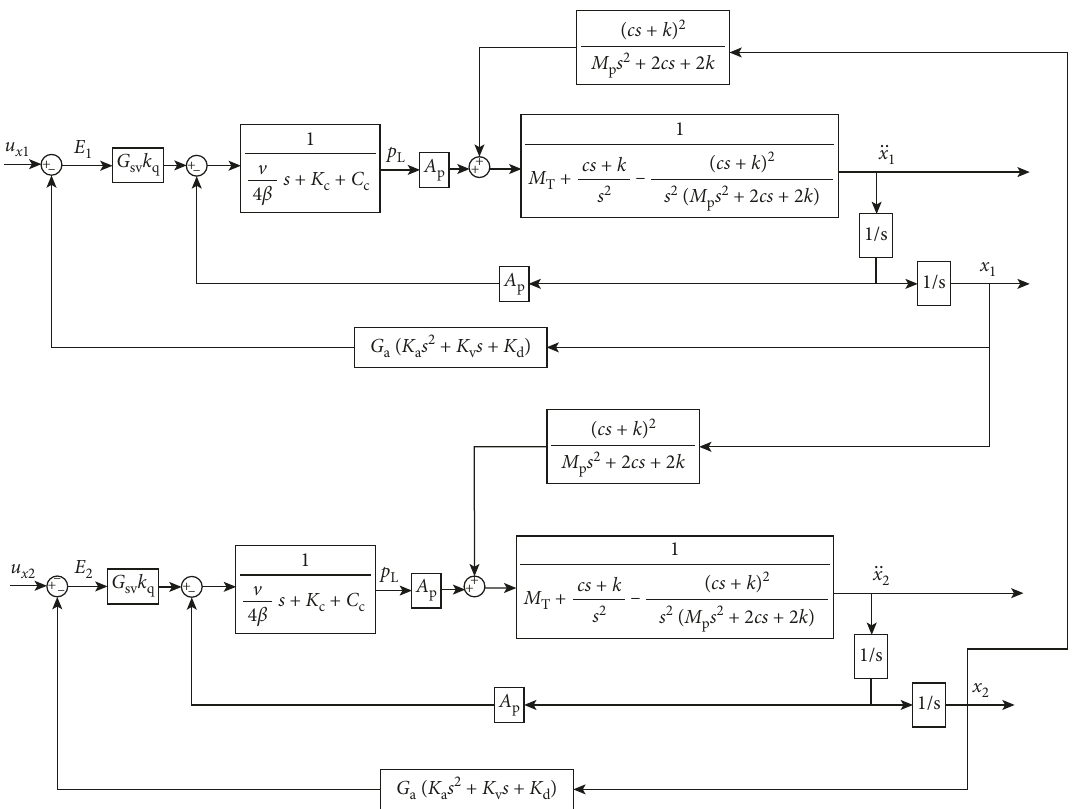
Figure 2: Transfer function block diagram of dual shaking tables with specimen.